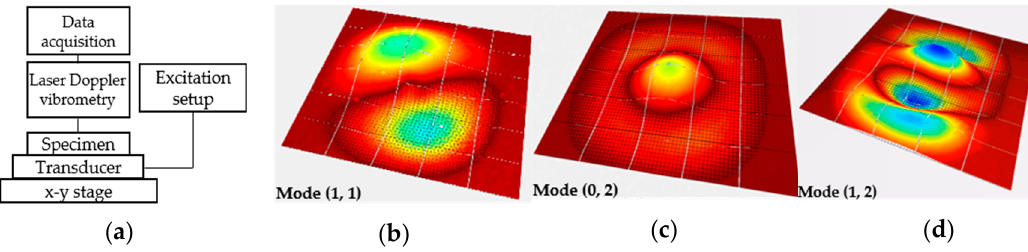
Figure 4. ( a ) Schematic diagram of the resonance frequency method. Vibration mode shapes measured using laser Doppler vibrometry for ( b ) (1, 1); ( c ) (0, 2); and ( d ) (1, 2) modes.